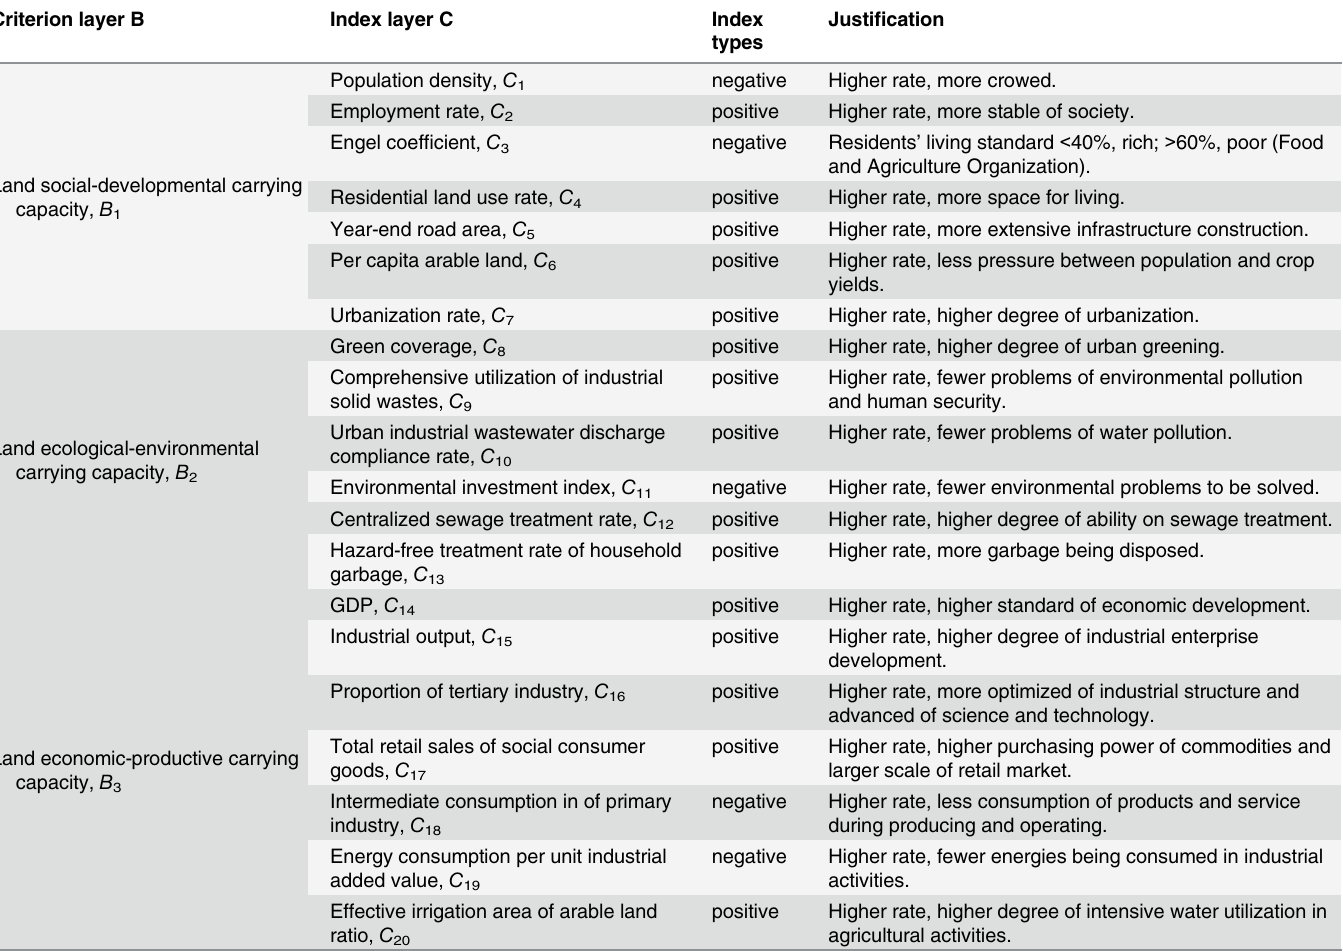
Table 3. ISM framework for assessing LCC.